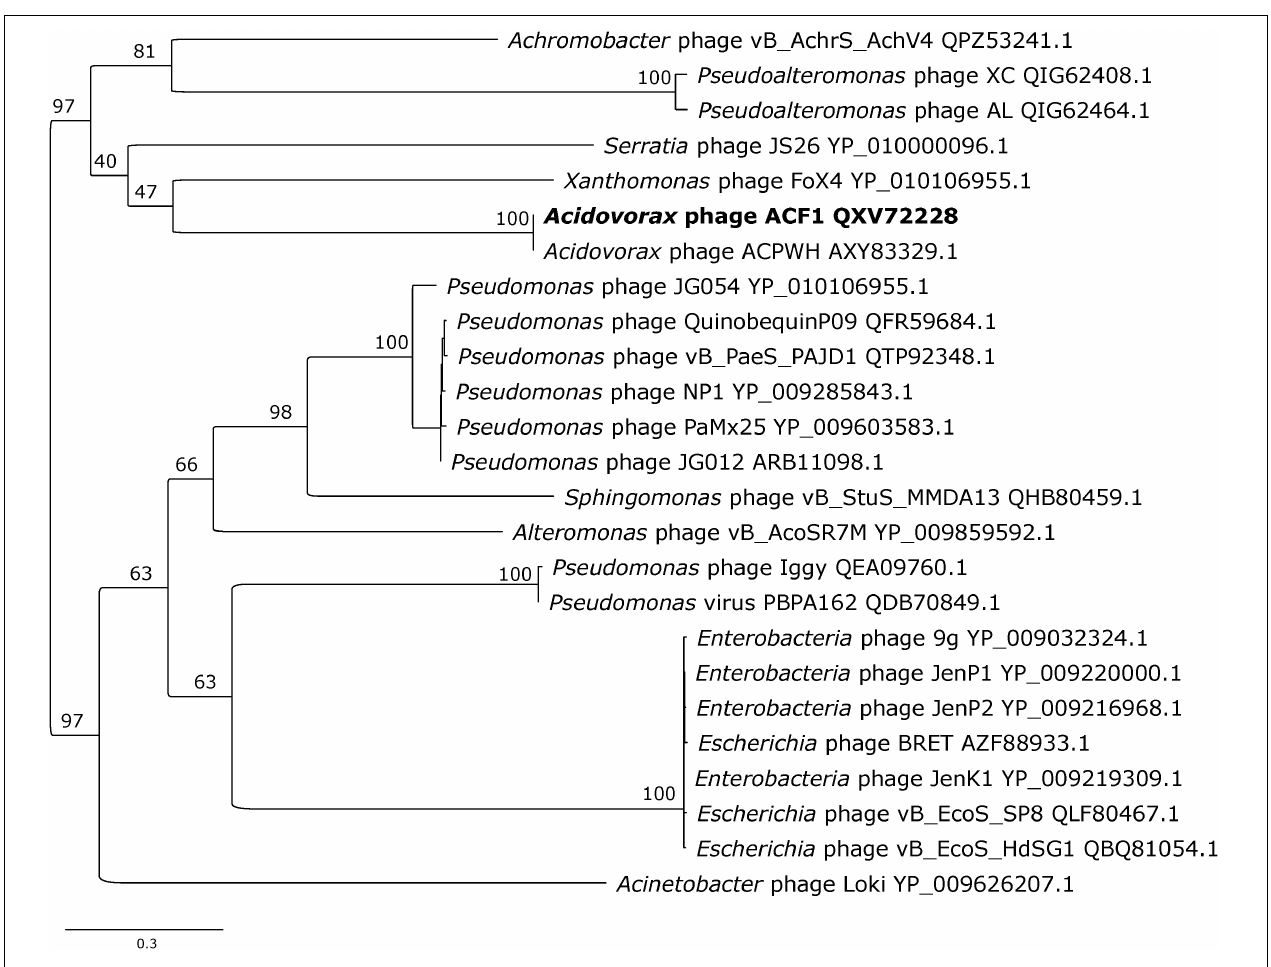
FIGURE 9 | Maximum likelihood tree based on the DNA polymerase of Acidovorax phage ACF1 (bold font) and homologous proteins from other phages of the Siphoviridae family. The numbers on the nodes indicate ultrafast bootstrap values. The tree was midpoint rooted. The scale bar represents the number of expected substitutions per site under the best-fitting LG + I + G4